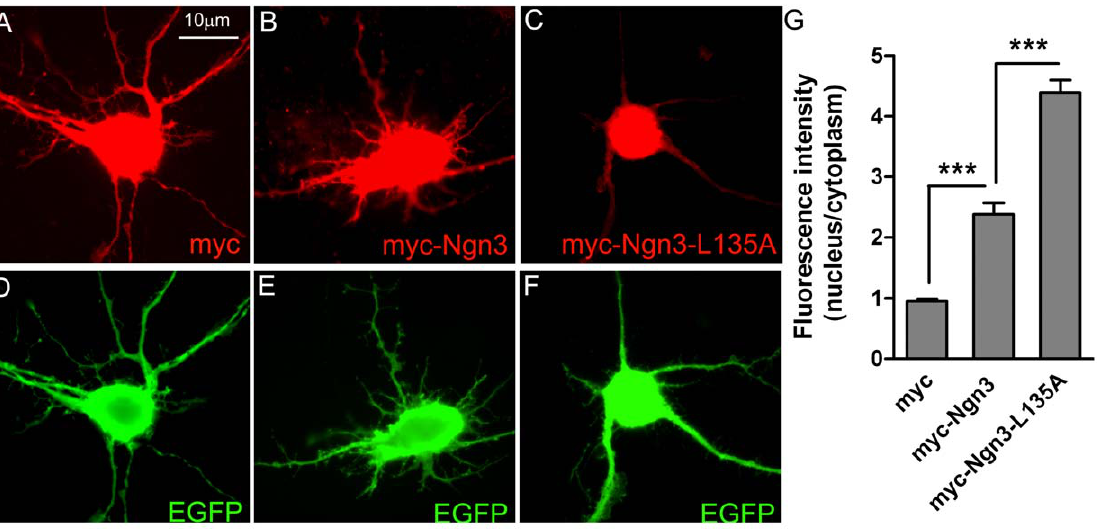
Figure 4. Point mutation in NES2 induces nuclear accumulation of full-length Ngn3. ( A–F ) Cultured neurons were co-transfected with constructs encoding EGFP and full-length myc-tagged wild-type Ngn3 (myc-Ngn3), Ngn3 with leucine 135 mutated to alanine (myc-Ngn3-L135A) or empty vector expressing myc-tag. After 16 h, double immunostaining was performed using an anti-myc antibody to determine subcellular localization of wild-type and mutated myc-Ngn3 (A-C) and an anti-GFP antibody to visualize neurons at full (D-F). ( G ) Quantification of the relative fluorescence in the cell nucleus versus the cytoplasm of neurons. Graphs show the results (mean + s.e.m.) of at least three experiments. Significance levels were determined using a Student’s t-test; *** p , 0.001 versus values of neurons transfected with plasmid expressing myc-tag.